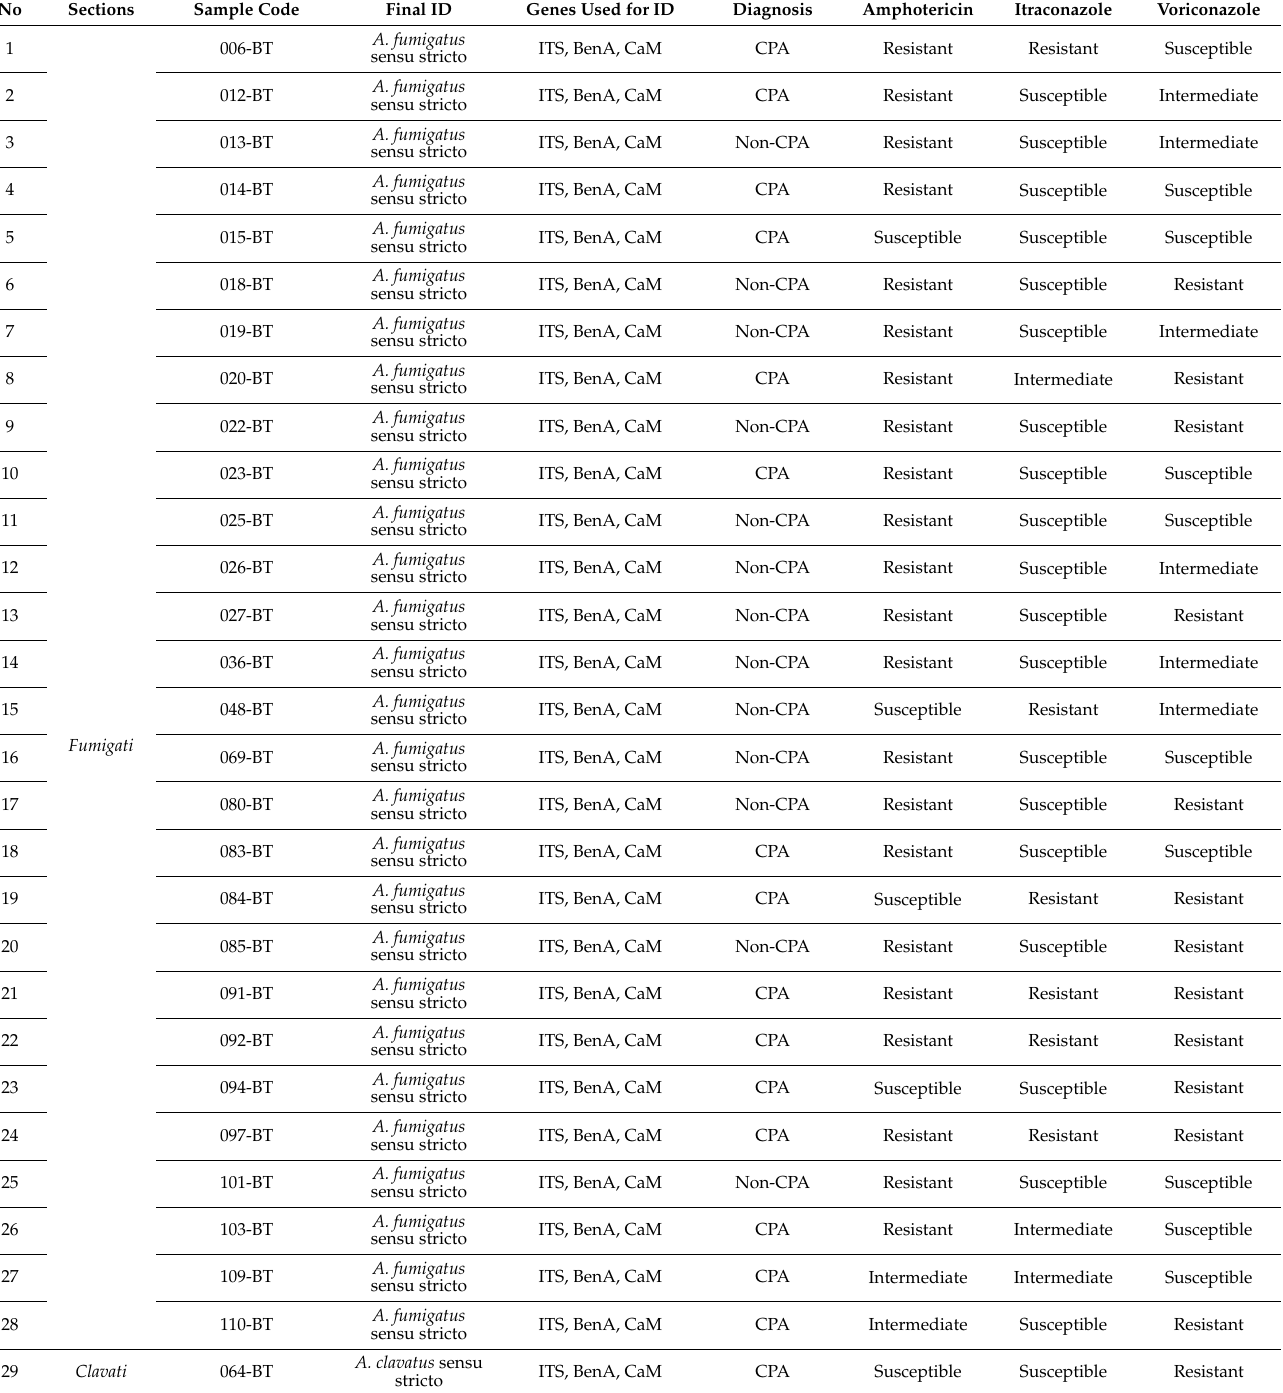
Table 2. Molecular identification of all